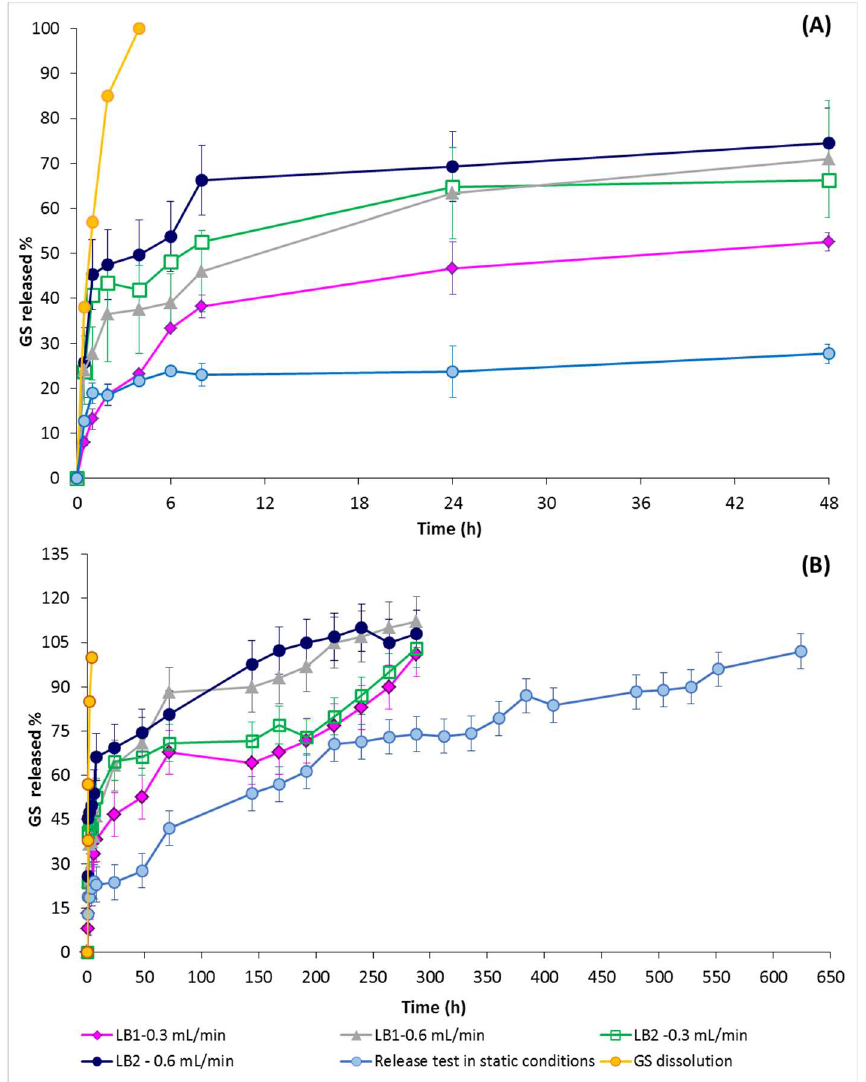
Figure 7. GS in vitro release profiles as tested in static and dynamic conditions: ( A ) GS release in the first 48 h test; and ( B ) in vitro release profiles at GS release completion.